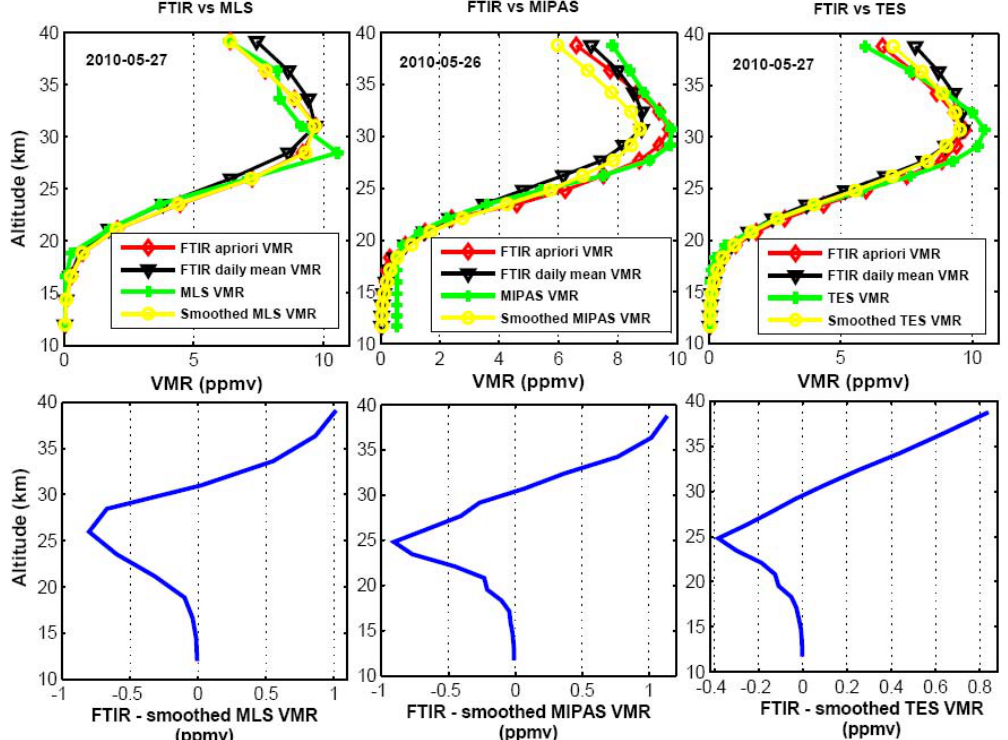
Fig. 5. Top: Comparisons of O 3 VMR profiles on 26 and 27 May 2010. FTIR a priori (red with diamond symbol) and FTIR daily mean (black with triangle symbol) are shown in top panels, MLS smoothed (yellow with circle) and MLS (green with plus sign symbol) (left top panel), MIPAS smoothed (yellow with circle) and MIPAS (green with plus sign symbol) (middle top panel) and TES smoothed (yellow with circle) and TES (green with plus sign symbol) (right top panel). Bottom: absolute differences (in ppmv) between FTIR and smoothed MLS (left bottom panel), FTIR and smoothed MIPAS (middle bottom panel) and FTIR and smoothed TES (right bottom